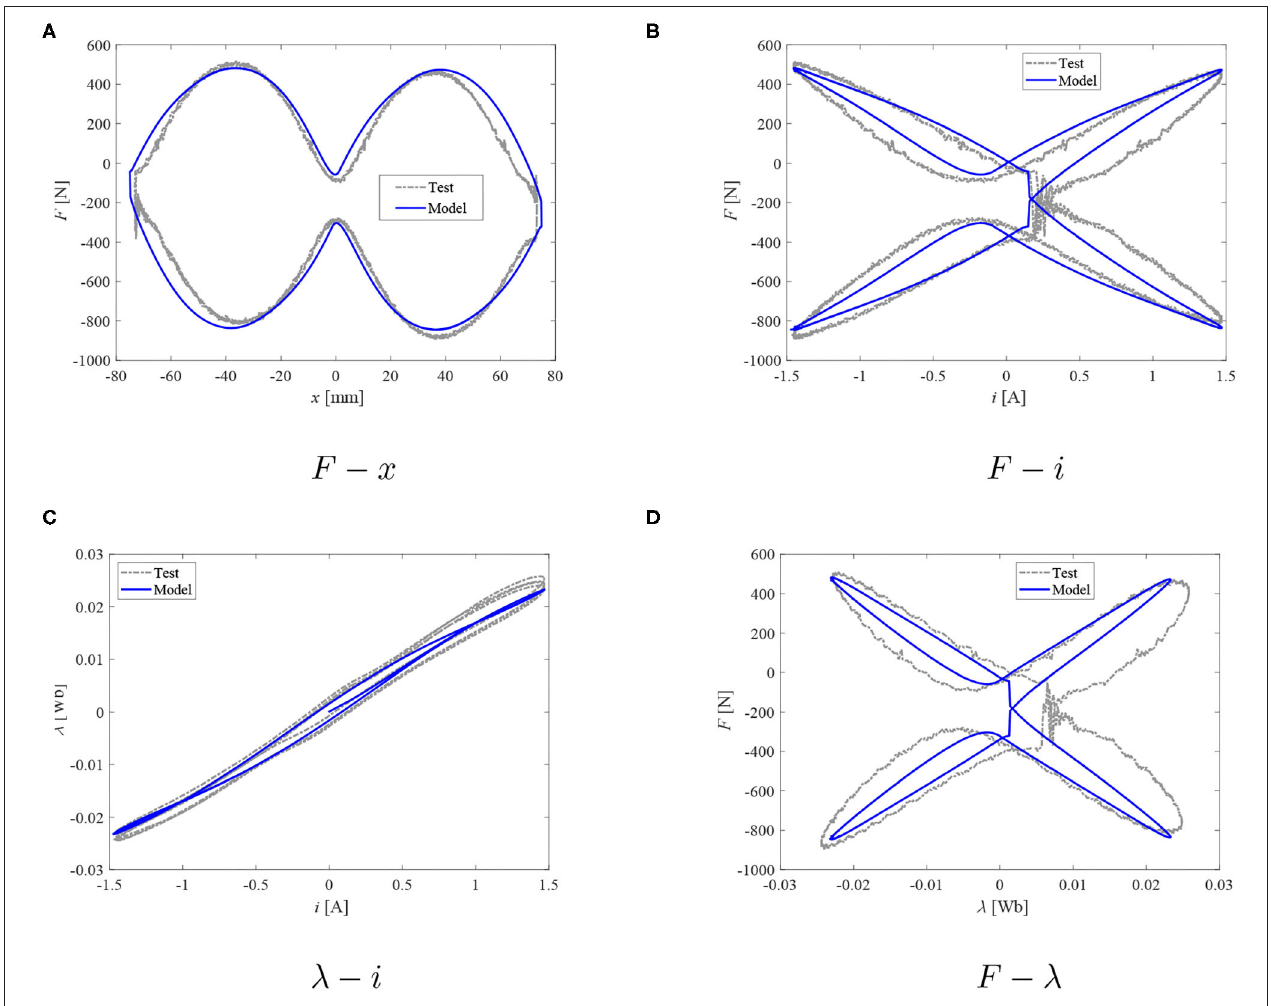
FIGURE 9 | Damper model: measured force and reconstructed flux vs. model data; I = 1.5 A. (A) F − x . (B) F − i . (C) λ − i . (D) F − λ